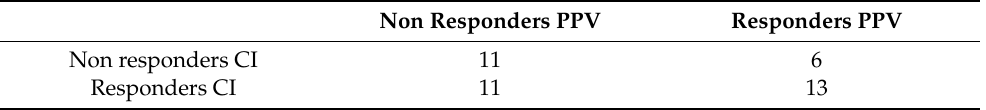
Figure 1. Correlation analysis. Upper panel: correlation between the absolute change in proportion of perfused small vessels (PPV) after fluid challenge and the absolute change of cardiac index (CI) ( A ), and between the absolute change in mean flow index (MFI) and the absolute change of CI ( B ) after fluid challenge. Lower panel: correlation between the absolute change in PPV after fluid challenge and the baseline values of PPV ( C ), and between the absolute change in MFI after fluid challenge and the baseline values of MFI ( D ). Table 3. Proportion of patients responding to fluid challenge according to changes in cardiac index (CI, i.e., >10%) or to changes in the proportion of perfused small vessels (PPV, >10%). Total of fluid challenge =